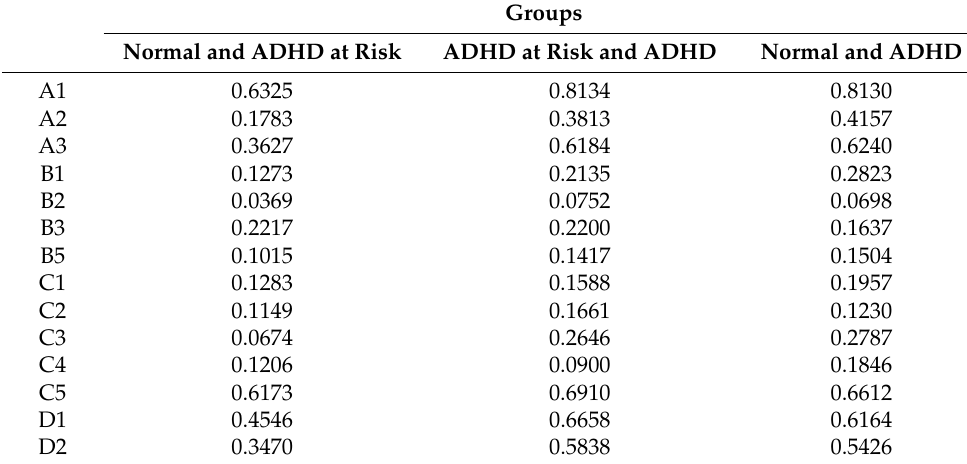
Table 13. BD for each indicator for each group.